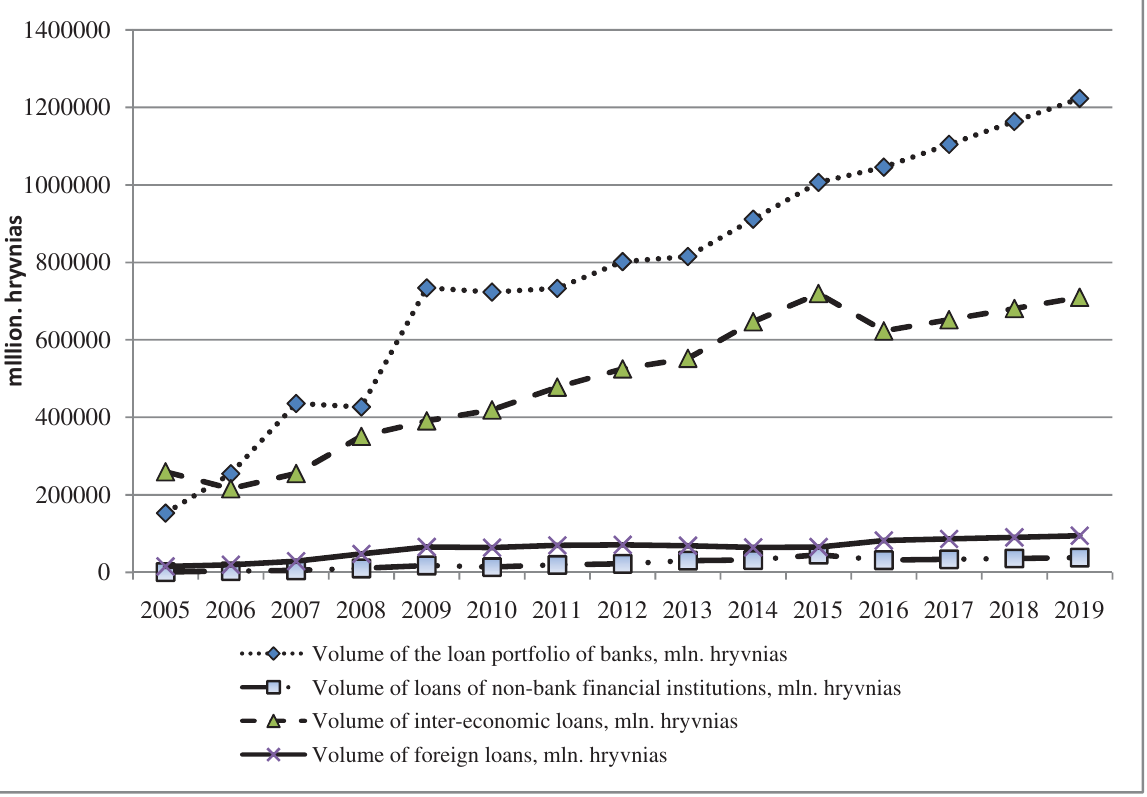
Fig. 1. Dynamics of the actual and forecast indicators in the volume of loans by segments of the credit market of Ukraine during 2005-2019, million